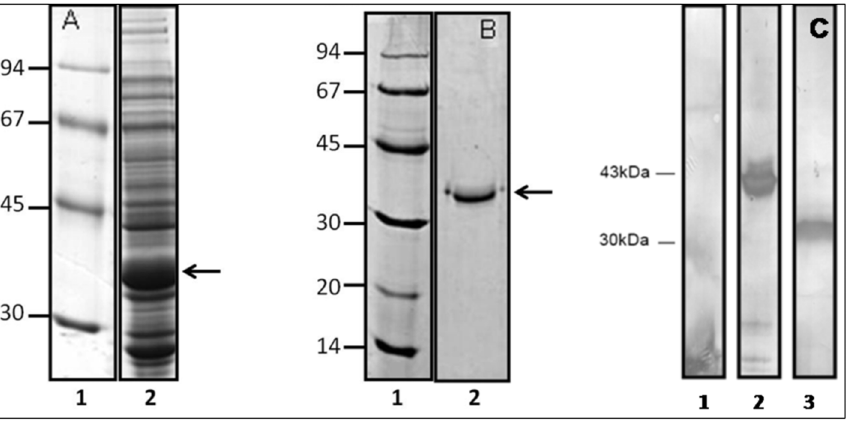
Figure 2. SDS-PAGE to verify protein induction (A) and 14-3-3 recombinant protein purification (B). Gels were stained with Phast Gel Coomassie R350. (A) 1: LMW ladder (low molecular weight, GE Life Science), 2:5 h of induction with 0.4 mM IPTG at 37 u C. (B) 1: LMW, 2: purified protein. The arrow indicates the purified 14-3-3 recombinant protein. (C) Immunoblot to verify the reactivity of polyclonal serum anti-14-3-3. (1) Pre- immune serum 1:100– control, (2) full recombinant 14-3-3 protein and (3) cleaved 14-3-3 protein induced for 2 h.